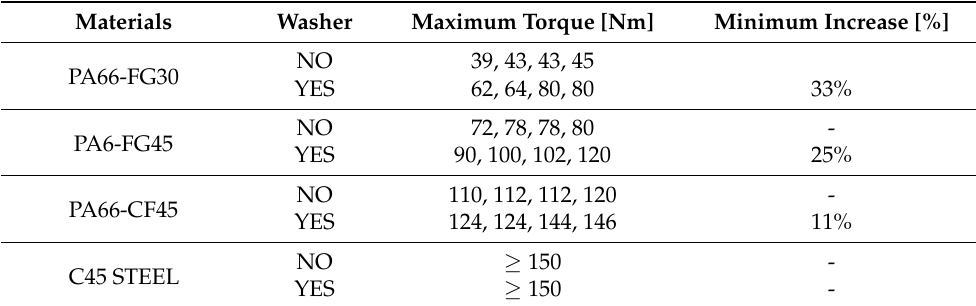
Table 2. Maximum torque results (for M12 class 12.9).